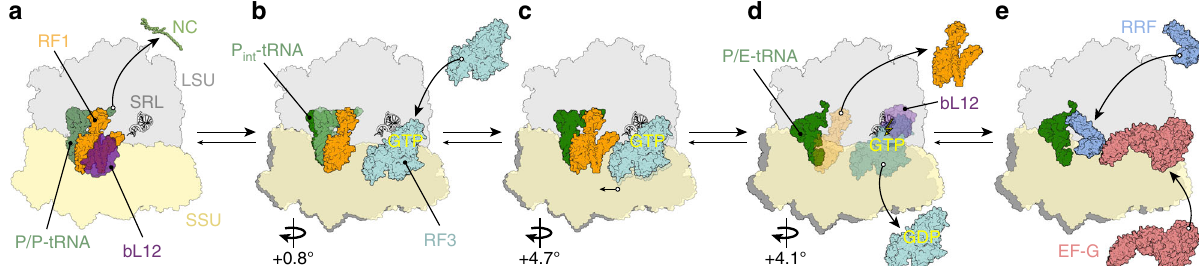
Fig. 7 Model for RF3-mediated dissociation of RF1 from the ribosome. a Binding of decoding release factors, such as RF1 (orange) to the non-rotated termination state ribosome, leads to release of the nascent polypeptide chain (NC) from the P-site tRNA (green). Binding of RF1 to the ribosome is facilitated by interaction of bL12 CTD (purple) with domain 1 of RF1. b RF3 (cyan) in the GTP conformation binds to the ribosome-RF1 complex. RF3 binding induces a slight rotation of the SSU that promotes formation of the partially rotated P-site tRNA conformation (P int -tRNA). c Additional SSU rotation and head swivel stabilizes domain I of RF1 and induces a closed conformation of uL11 (Fig. 5b, c). d Further SSU rotation leads to destabilization of RF1, promoting its dissociation from the ribosome, as well as accommodation of RF3 on the LSU in close proximity to the sarcin-ricin loop (SRL), thus facilitating hydrolysis of GTP to GDP and dissociation of RF3-GDP from the ribosome. e The rotated ribosome with a P/E-tRNA is recognized by the ribosome recycling factor (RRF) and EF-G, which recycle the post-termination complex for the next round of